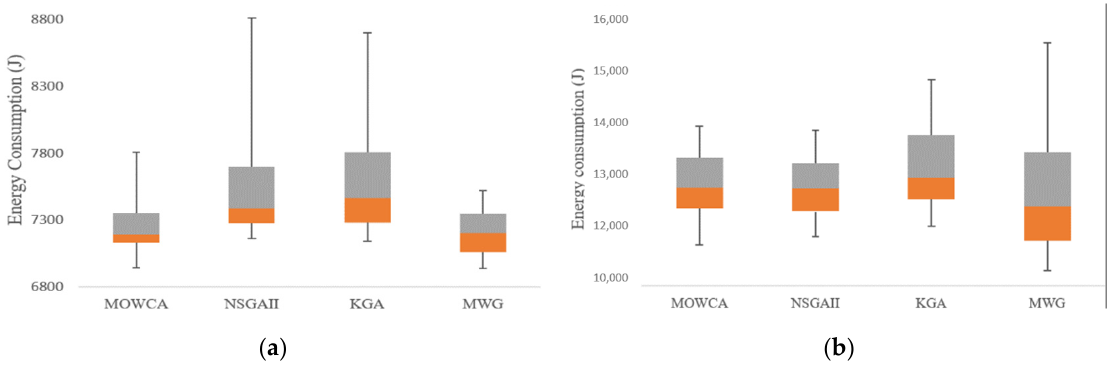
Figure 3. Comparison between algorithms due to the distribution of different solutions’ energy consumption in the resulted Pareto after 100 iterations for ( a ) 100 data items and ( b ) 400 data items.